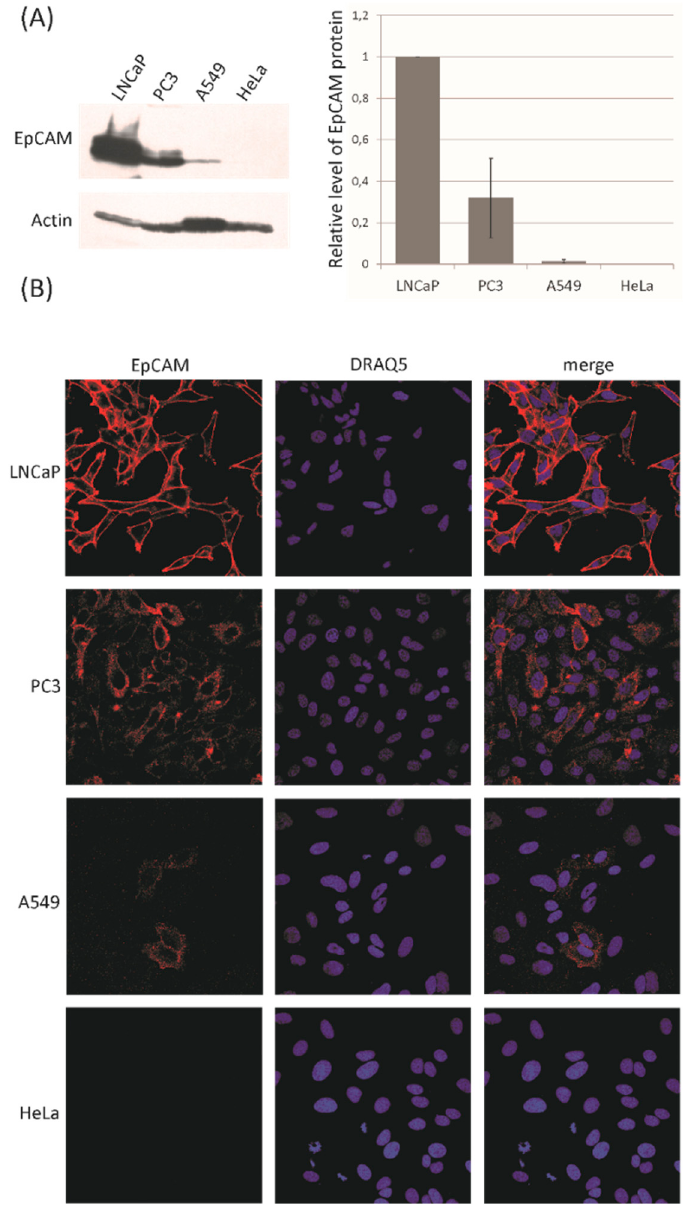
Figure 1. Epithelial-cell-adhesion-molecule (EpCAM) expression in selected cancer cell lines. ( A ) Whole cell lysates were analyzed by Western blotting with anti-EpCAM and anti-actin antibodies (3 independent experiments). The level of Actin protein was chosen as a loading control. The bar graph shows the densitometric quantification of the Western blots and it presents the relative expression of EpCAM protein in reference to the level of EpCAM in human metastatic prostate adenocarcinoma cells (LNCaP) cells (arbitrarily set to 1; n = 3, ±SD). ( B ) Immunocytochemical analysis was performed